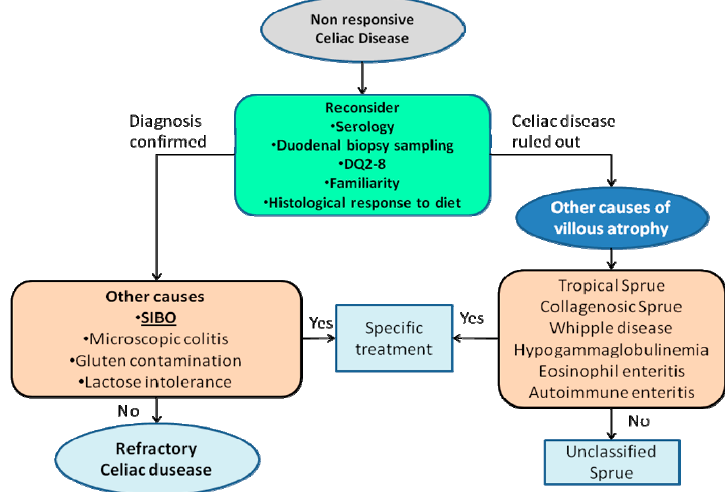
Figure 1. Stepwise approach to non-responsive celiac disease and the importance of SIBO recognition in this